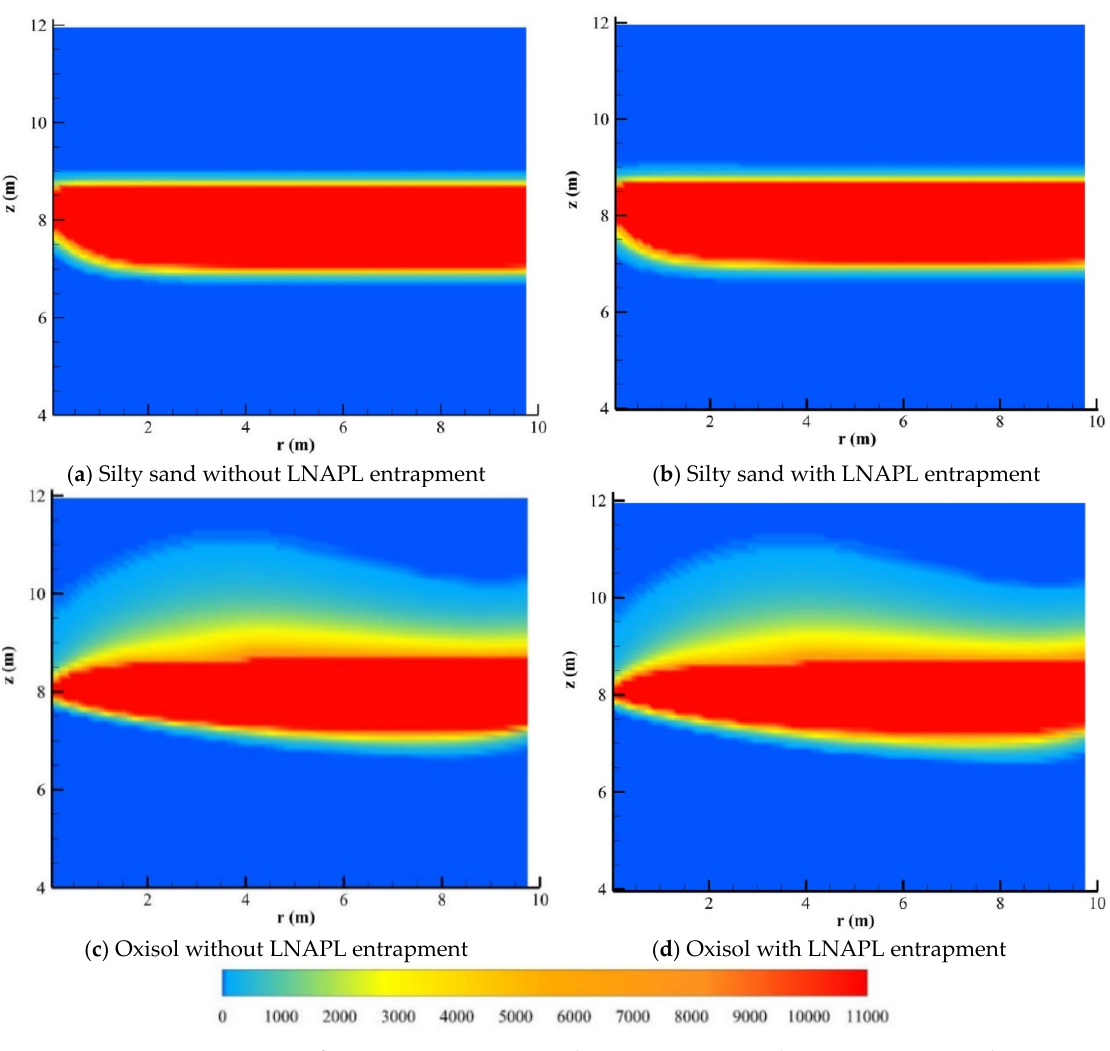
Figure 16. Concentration of LNAPL in an aqueous phase in response to the MPE system simulation without and with LNAPL entrapment.